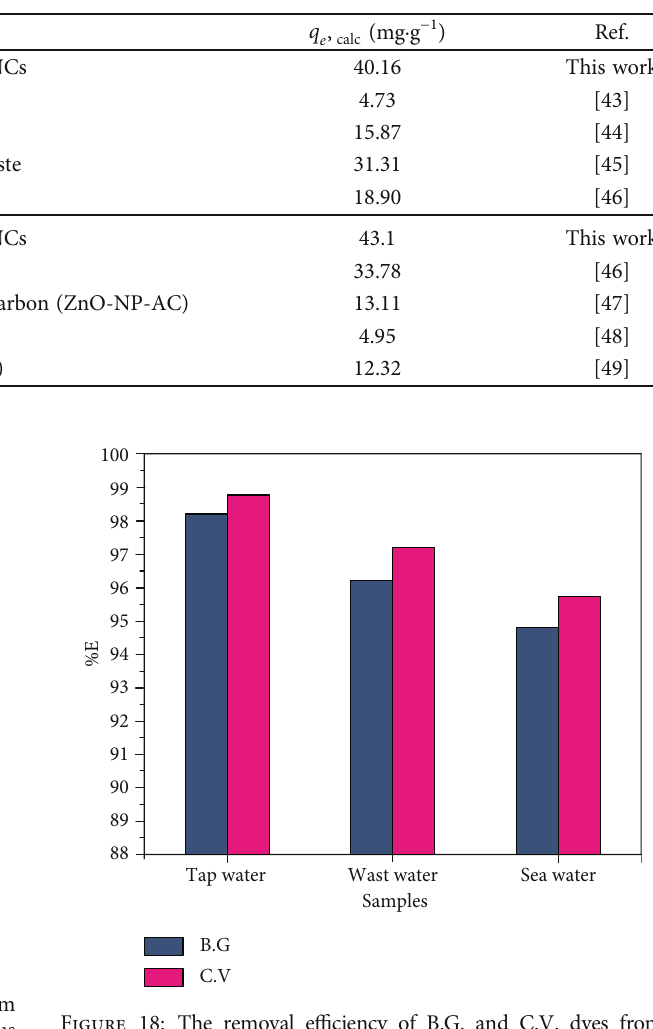
Table 3: The comparison of q